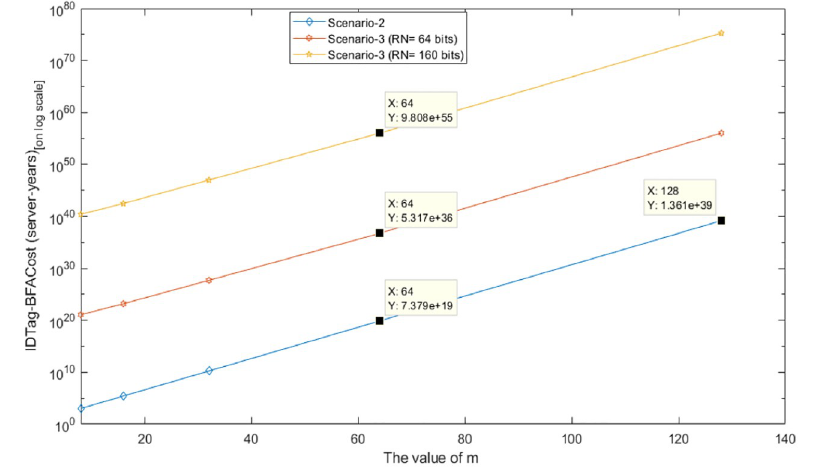
Fig 4. Costs of brute-force attack on IDTag versus the value of m